Question: Describe this figure in one sentence.
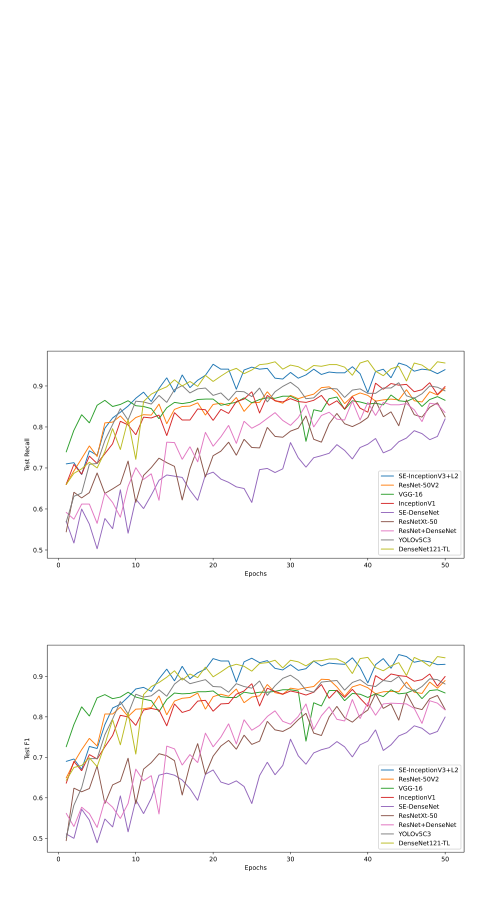
Answer: Comparison of the validation set Loss, Precision, Recall, and F1 for each classification